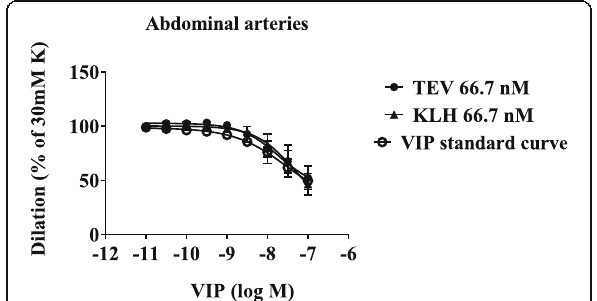
Fig. 3 Human abdominal subcutaneous arteries were pre-contracted with 30 mM potassium buffer. The curves show dilatation in response to increasing concentrations of VIP 10 − 11 to 10 − 7 M in the presence of 66.7 nM of the monoclonal antibody against CGRP (fremanezumab) or an isotype control (KLH). The data show mean±SEM, n =2 – 4 for each concentration. K:potassium; TEV:Teva; VIP:vasoactive intestinal peptide